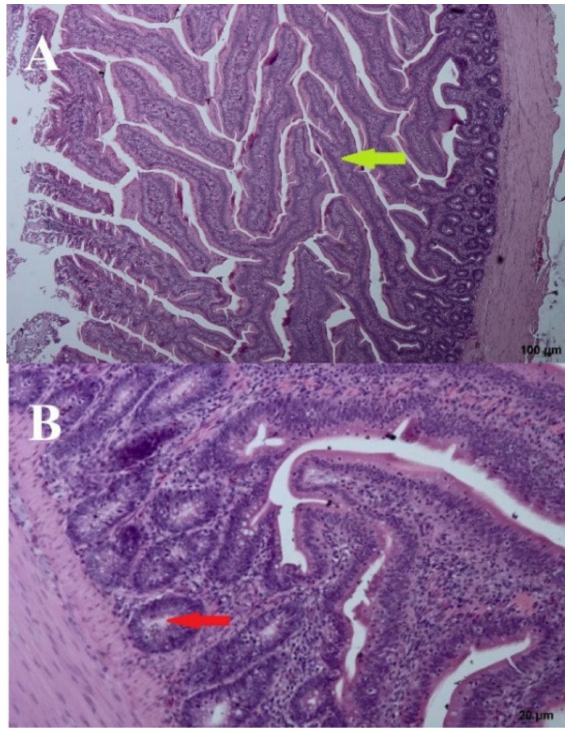
Figure 6. B. subtilis 67—( A ) Cross section through the intestine—100 µ m and ( B ) crypts—20 µ m. Arrows: bold green—villi,